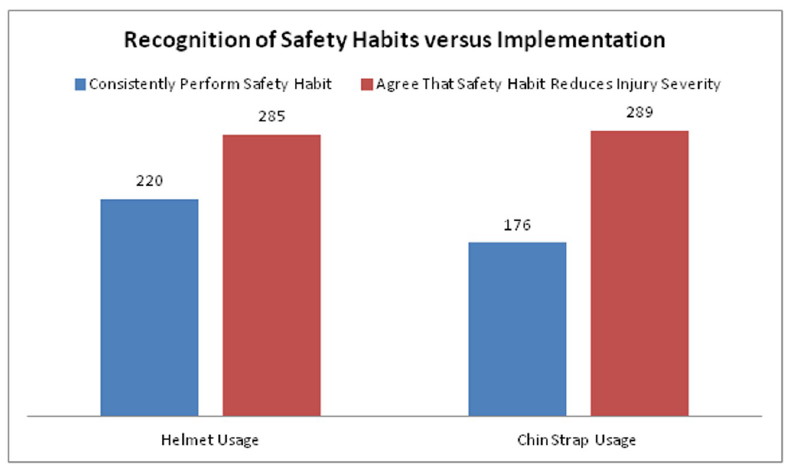
Fig 1. Knowledge versus usage of safety gear among motorcycle taxi drivers.